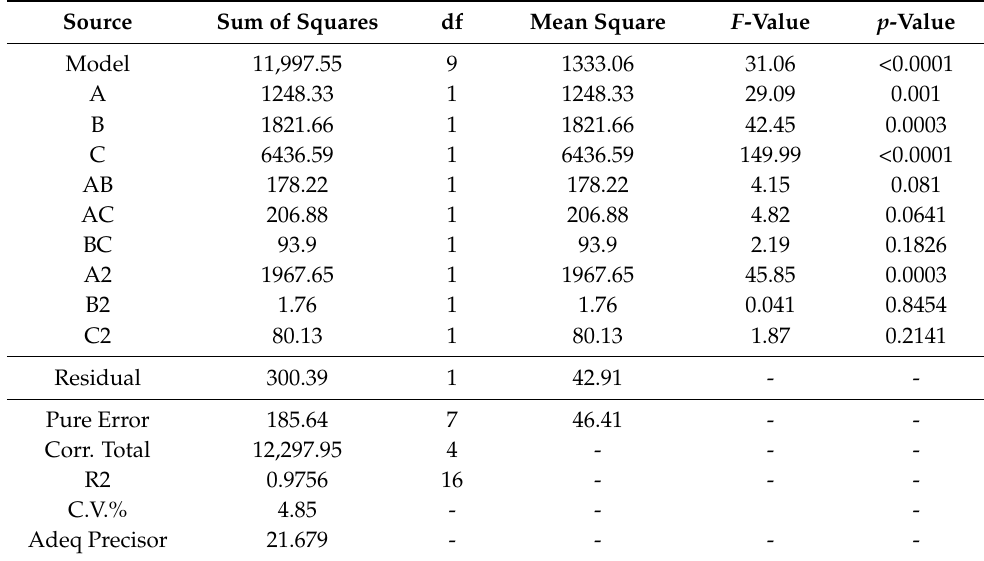
Table 2. ANOVA of quadratic model for responses of size.